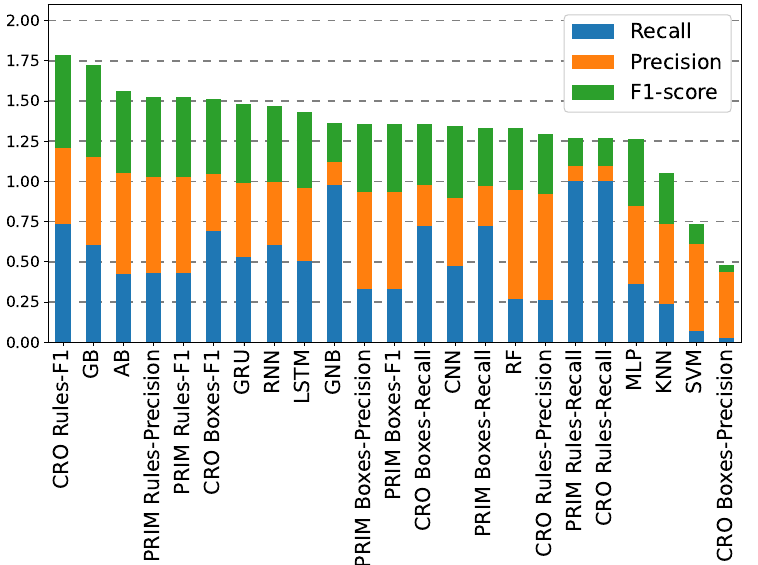
Figure 15. Comparison of the test performance of the different methodologies assessed for a time prediction horizon of +5